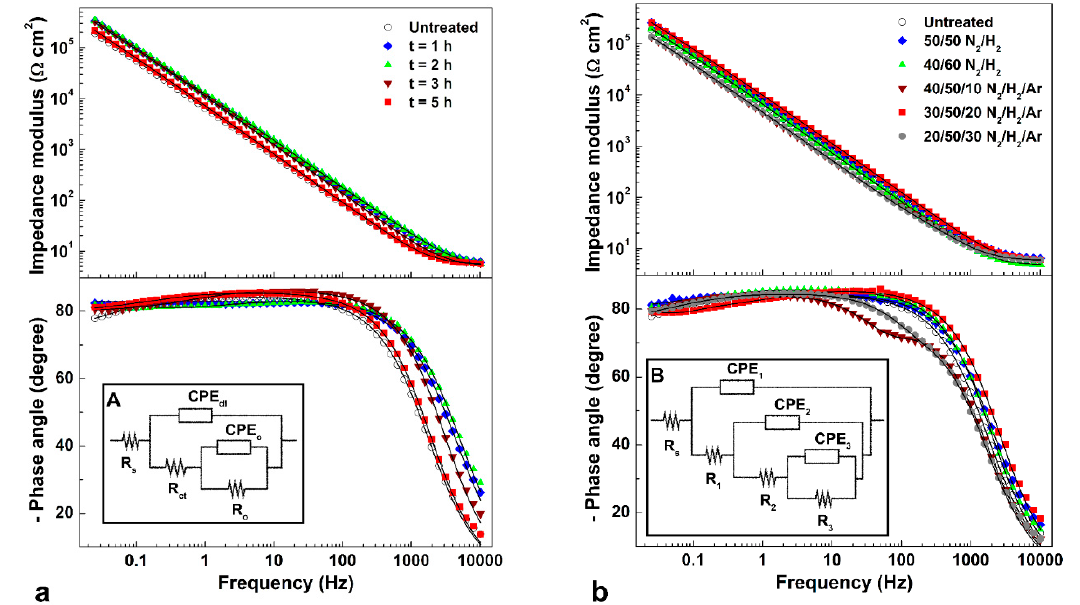
Figure 9. Bode plots of samples untreated, nitrided for 3 h, at 360 and 380 °C, using 50 vol.% N 2 + 50